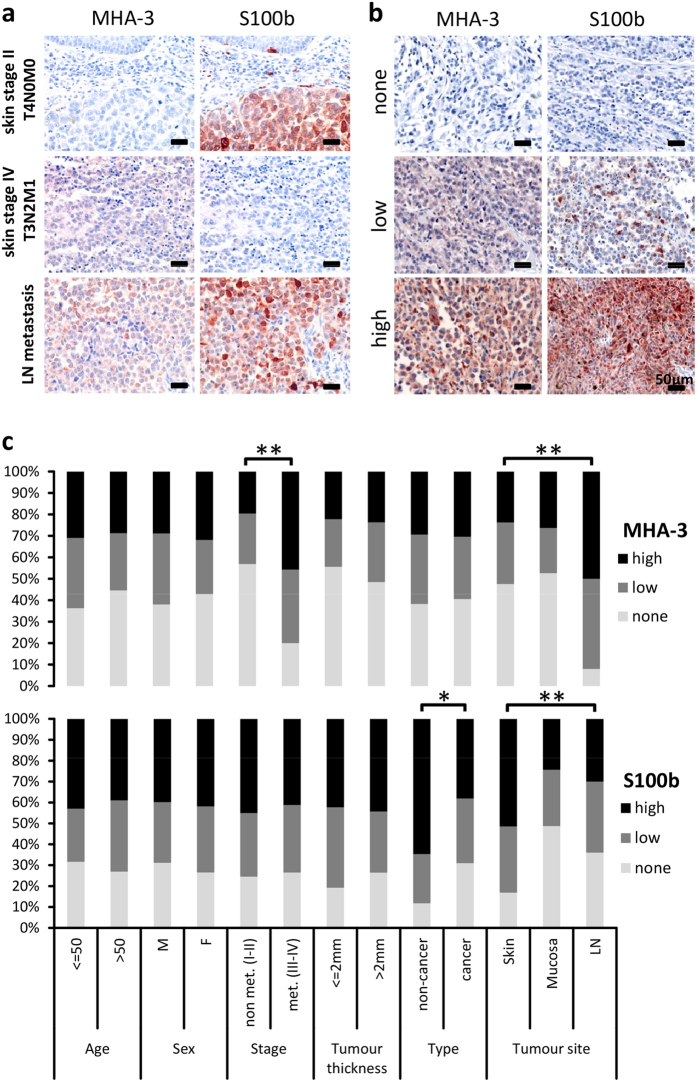
Association of MHA-3 staining with human melanoma.(a) Staining distribution of MHA-3 and S100b in low and high grade melanoma and lymph node biopsies. (b) Representative examples for scoring of MHA-3 and S100b staining are shown. (c) The overall scoring distribution for MHA-3 and S100b staining intensity in different clinicopathological groups. Unstained samples are shown in light grey, low staining in grey and high staining intensity in black. Clinicopathological groups along with age and sex of the patients are plotted on the x-axis. P-values are shown in the graph marked *for p < 0.01 and **for p < 0.0001.